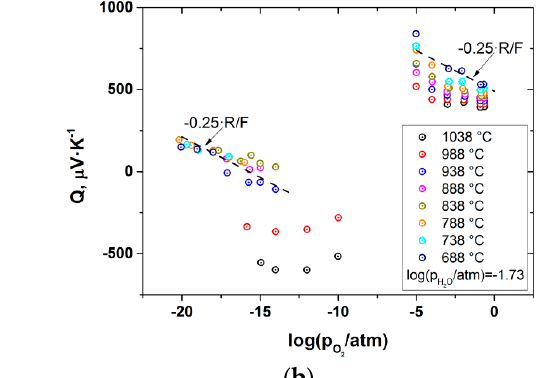
Figure 2. Total conductivity ( a ) and Seebeck coefficient ( b ) of BZY10 measured at log( p H 2 O/atm) = – 1.73 as a function of T and p O 2 . Points-experimental results, solid lines-calculation according to Equation (4) with parameters given in Table 1. Table 1. Fitted parameters of Equation (4)